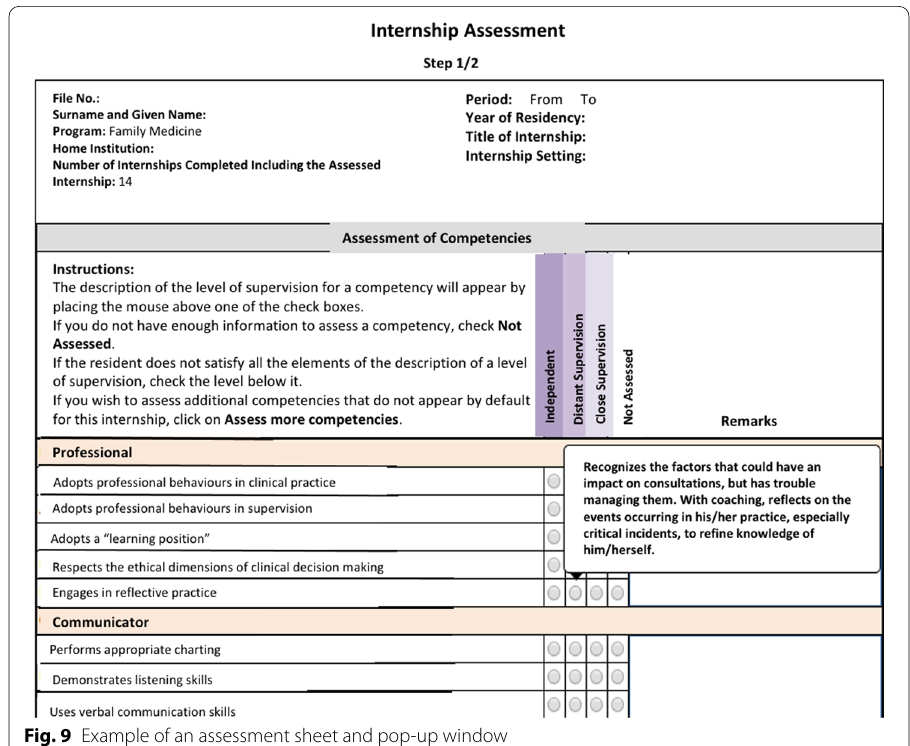
Fig. 9 Example of an assessment sheet and pop-up